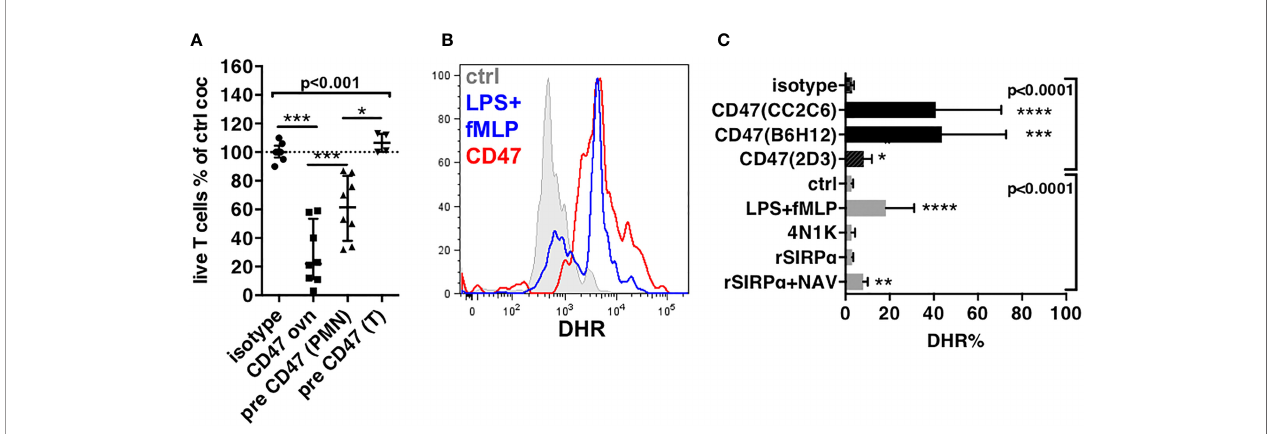
FIGURE 3 | Induction of production of ROS in PMNs. (A) Effect of pre-treatment of cells by the anti-CD47 mAb clone CC2C6 on cytotoxicity of PMNs to T cells. Cytotoxicity is represented by the percentages of live T cells compared to control coculture (ctrl coc). Pre-CD47, pre-treatment 30 min at 4°C. CD47 ovn, anti-CD47 mAb during overnight culture, n = 8, median and IQR. (B) Histograms of DHR staining in PMNs after exclusion of dead cells and doublets after 1-h stimulation. (C) Percentages of expression of DHR in PMNs after 1-h stimulation. N = 5 – 15 for antibodies, n = 5 for recombinants proteins or peptides. Gates are set on unstimulated stained cells. P -values from Kruskall – Wallis test indicated on top of groups, P -values from Dunn ’ s multiple comparison post-test on top of pairs: * P < 0.05; ** P < 0.01; *** P < 0.001; **** P <